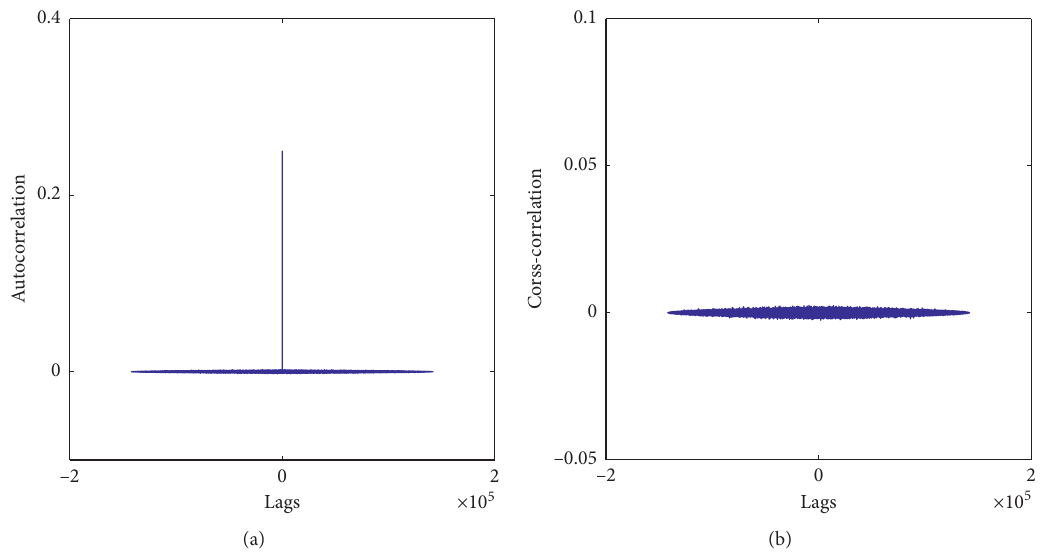
+ 10 − 12 (blue). (red) and x 0 0